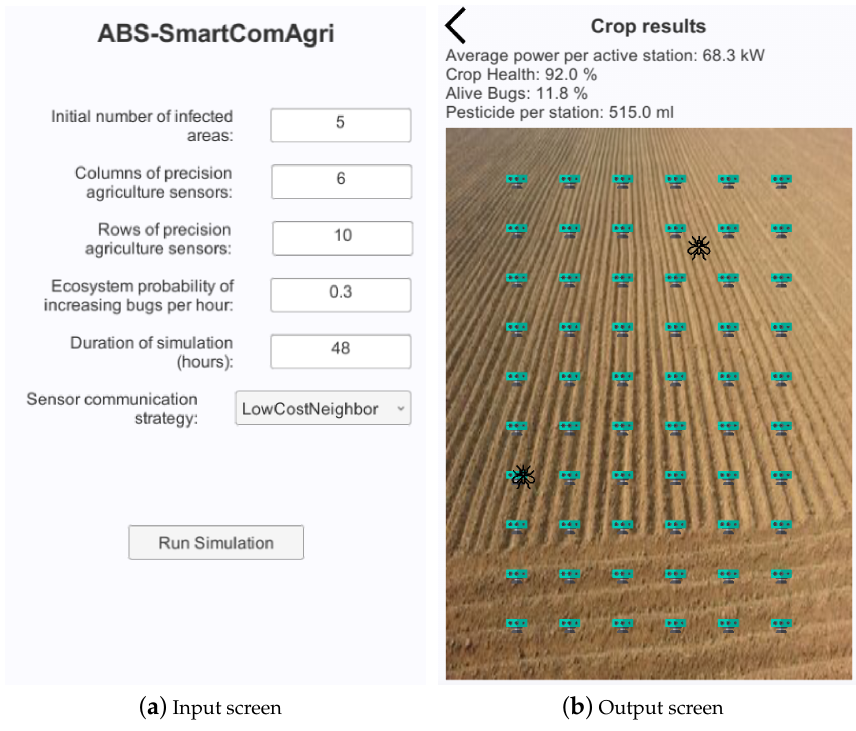
Figure 1. User interface (UI) of